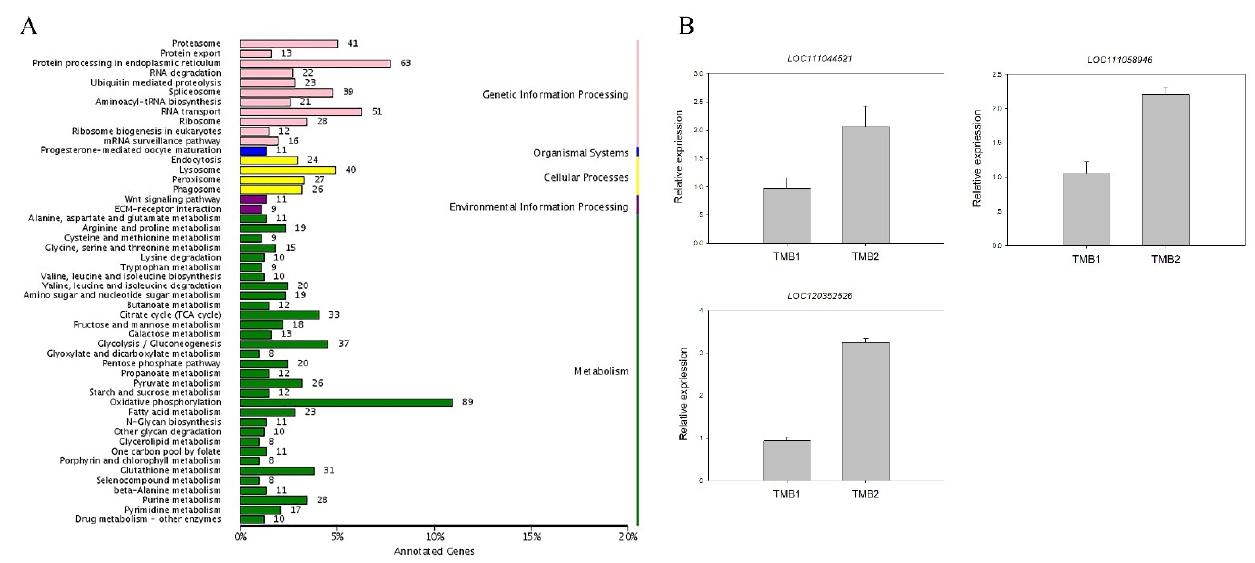
Figure 3. The changes of transcriptome of BPH with/without rifampicin treatment. ( A ) KEGG pathway enrichment analysis of the DEGs comparing BPHs feeding on the rice with/without rifampicin treatment. The abscissa indicates the ratio of the number of genes annotated to the pathway and the number of genes on the annotation, the ordinate indicates the name of the KEGG metabolic pathway. ( B ) Quantitative real-time PCR validation of the expression changes in the three genes enriched in the oxidative phosphorylation pathway. The error bars were S.D.